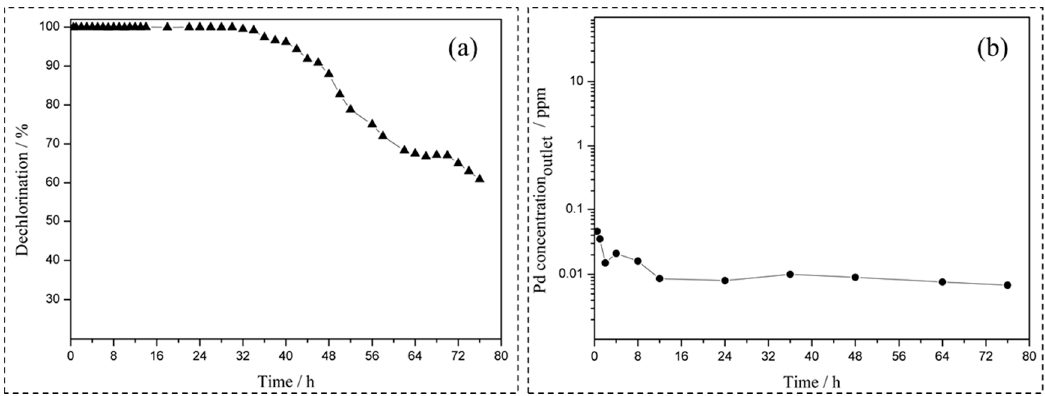
Figure 6. Dechlorination of 4-CP ( a ) and Pd outlet concentration ( b ) as a function of reaction time during HDC reaction in a Pd/CNT-Ni foam micro reactor. Reaction conditions: residence time (3 min), Pd loading (0.5 wt.%), FA/substrate molar ratio (5:1), 4-chlorophenol concentration (1 mmol/L).